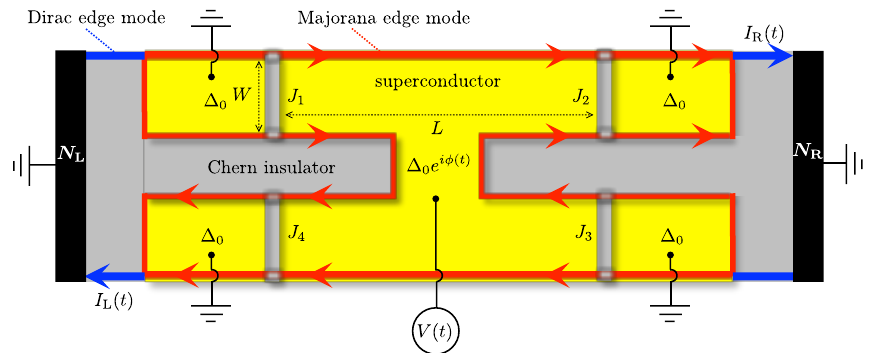
Figure 3: Same as Fig. 2, but now in a Chern insulator / superconductor heterostruc- ture with normal metal contacts ( N , N ) to detect the charge produced upon fusion L R (cid:82) V ( t ) dt = h / 2 e induces a 2 π of the edge vortices. An integrated voltage pulse phase shift over the four Josephson junctions J , J , J , J , which results in a current 1 2 3 4 ( t ) , I ( t ) into the left and right contact. While I pulse I and I separately, as well L R L R + I − I as the sum I , exhibit shot noise, the difference I becomes exactly noiseless L R L R for identical junctions J and J 1 3